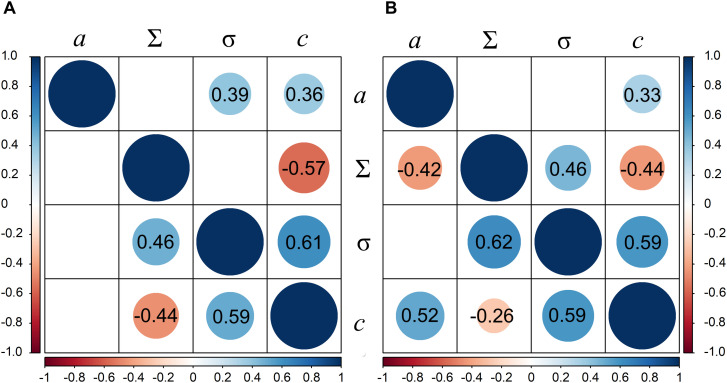
Correlation between thermal leaf growth (a), the leaf growth reduction point (Σ), the leaf growth arrest point (σ), and water deprivation tolerance (c) traits in perennial ryegrass panel; In (A) upper triangle represents forage cultivar group and lower triangle represents turf. (B) Upper triangle represents group of ecotypes of maritime origin and lower triangle represents group of ecotypes of continental origin.